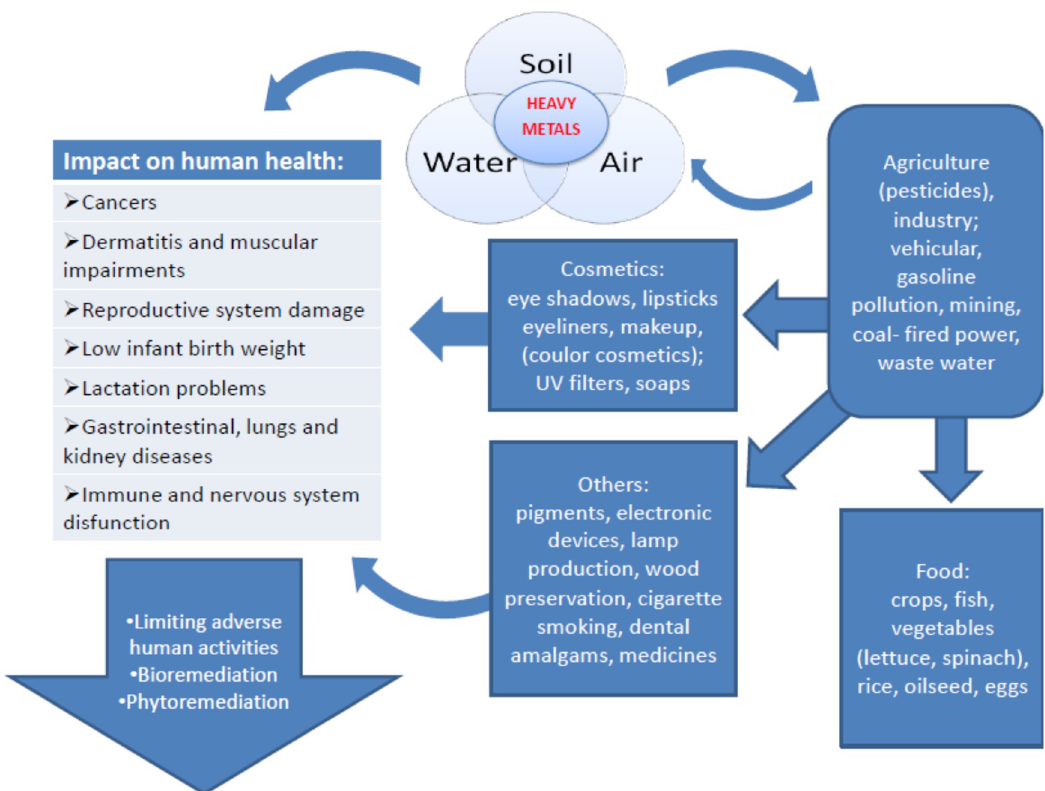
Figure 1. Routes of exposure, the impact of toxic metals on human health, and the ways of limiting the risk caused by contact with these elements (large arrow on the left). These adverse effects are caused by direct exposure to the toxic metals in the environment or indirectly due to anthropogenic activity.